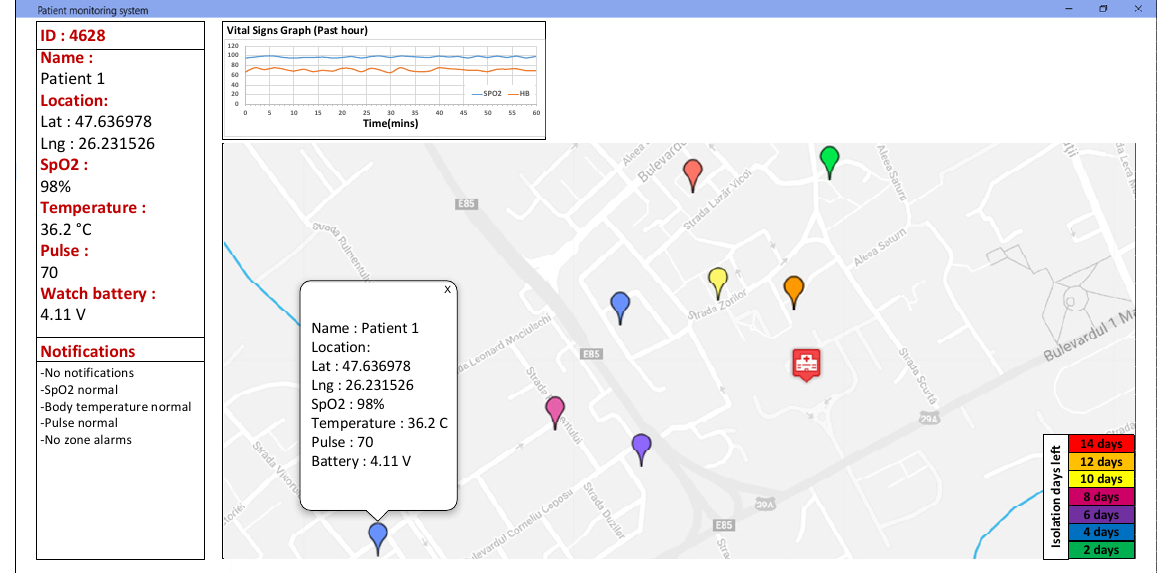
Figure 10. IoT multi-sensor patient monitoring application dashboard.